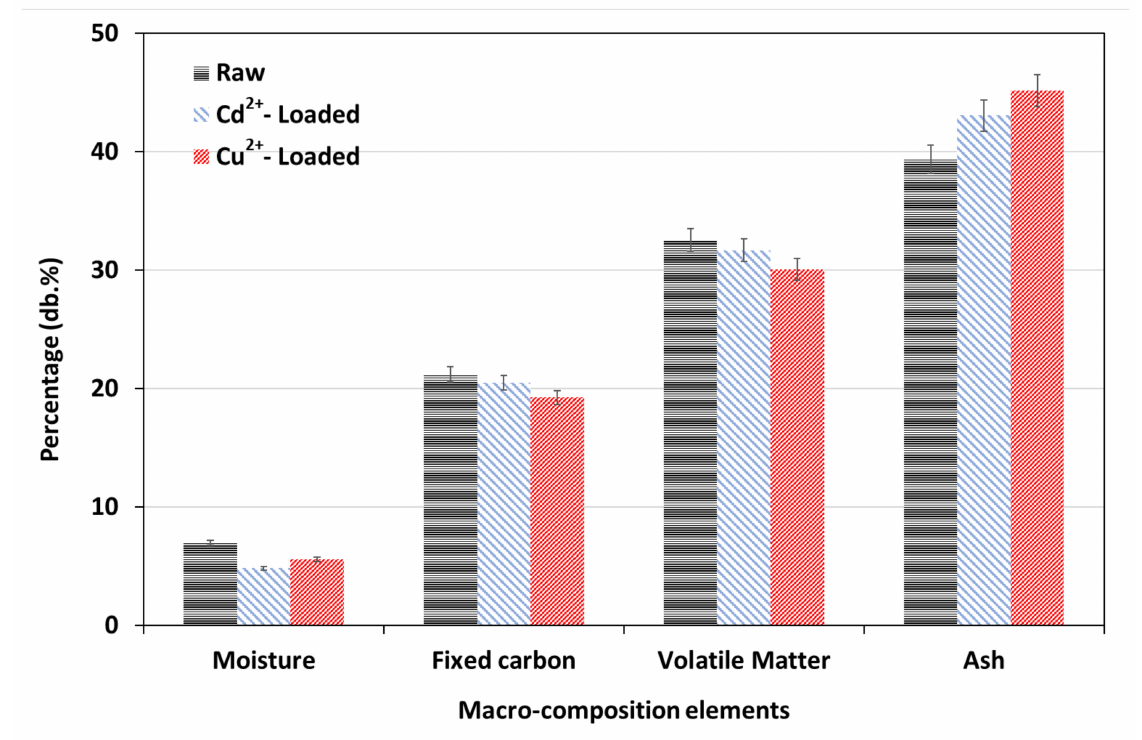
Figure 9. Proximate analysis of lignite before and after copper and cadmium